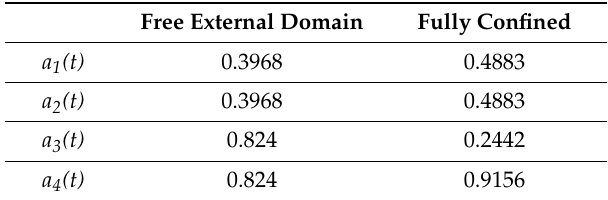
Figure 18. Corresponding POD time coe ffi cient a i (t) for both the free and fully confined external domain at Re = 6440; ( a ) free ( b ) fully confined. Table 2. Frequency [Hz] of time coe ffi cient for both the fully confined and free external domain at Re =